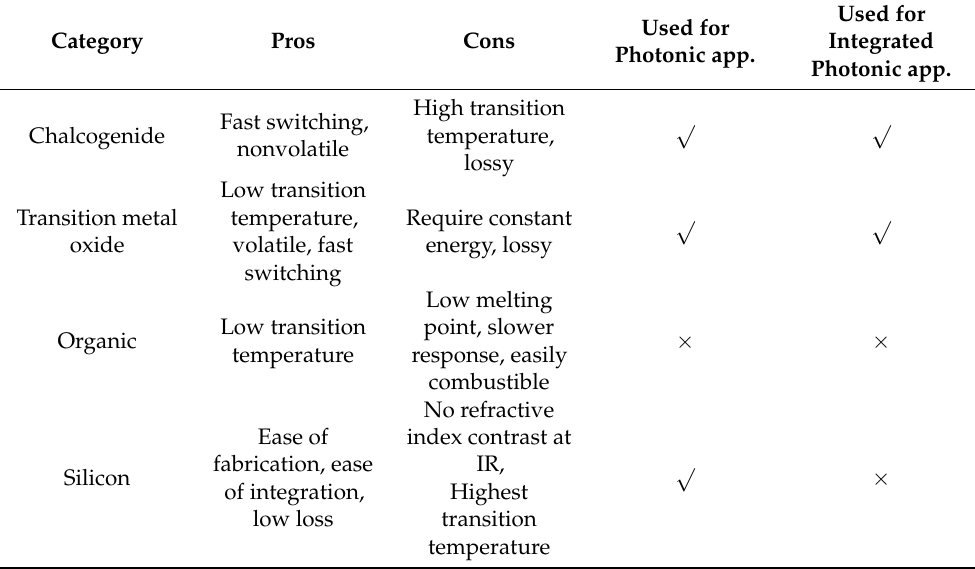
Table 2. Summary of pros and cons of PCM categories; the last two columns denote whether there has been a report in the literature concerning the use of each category for any type of photonic application or integrated photonic application.